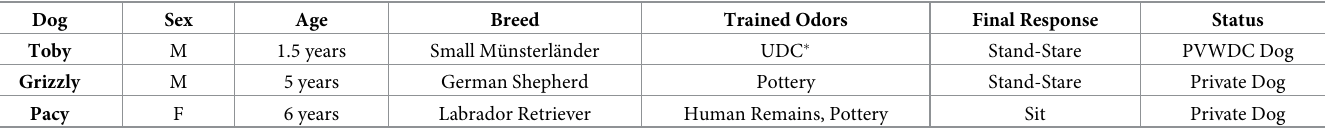
Table 1. Detection dogs used in this study.